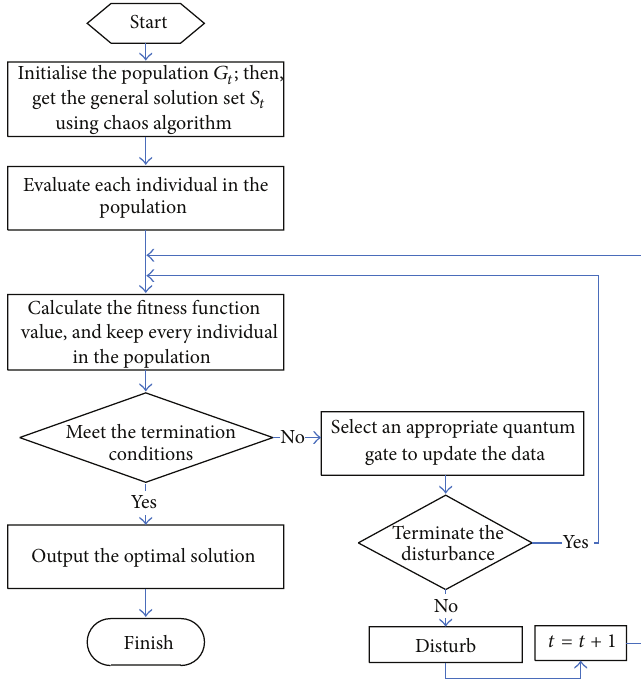
Figure 1: Flow chart of the VSS